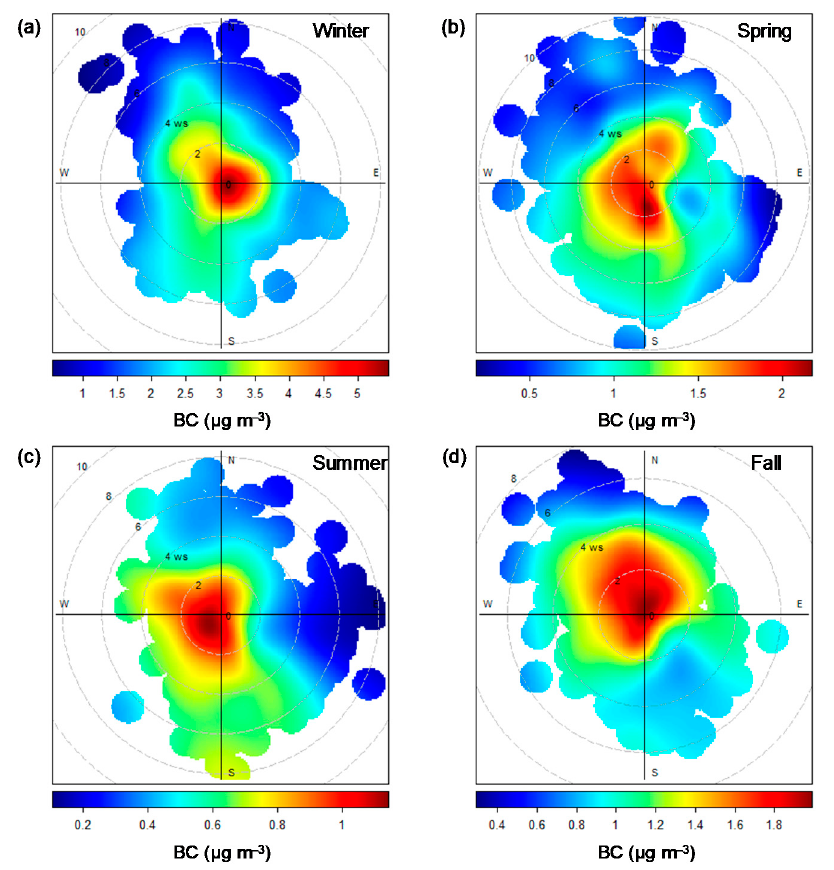
Figure 8. Bivariate polar plots for hourly BC mass concentration in the four seasons: ( a ) winter, ( b ) spring, ( c ) summer, and ( d ) fall, respectively.